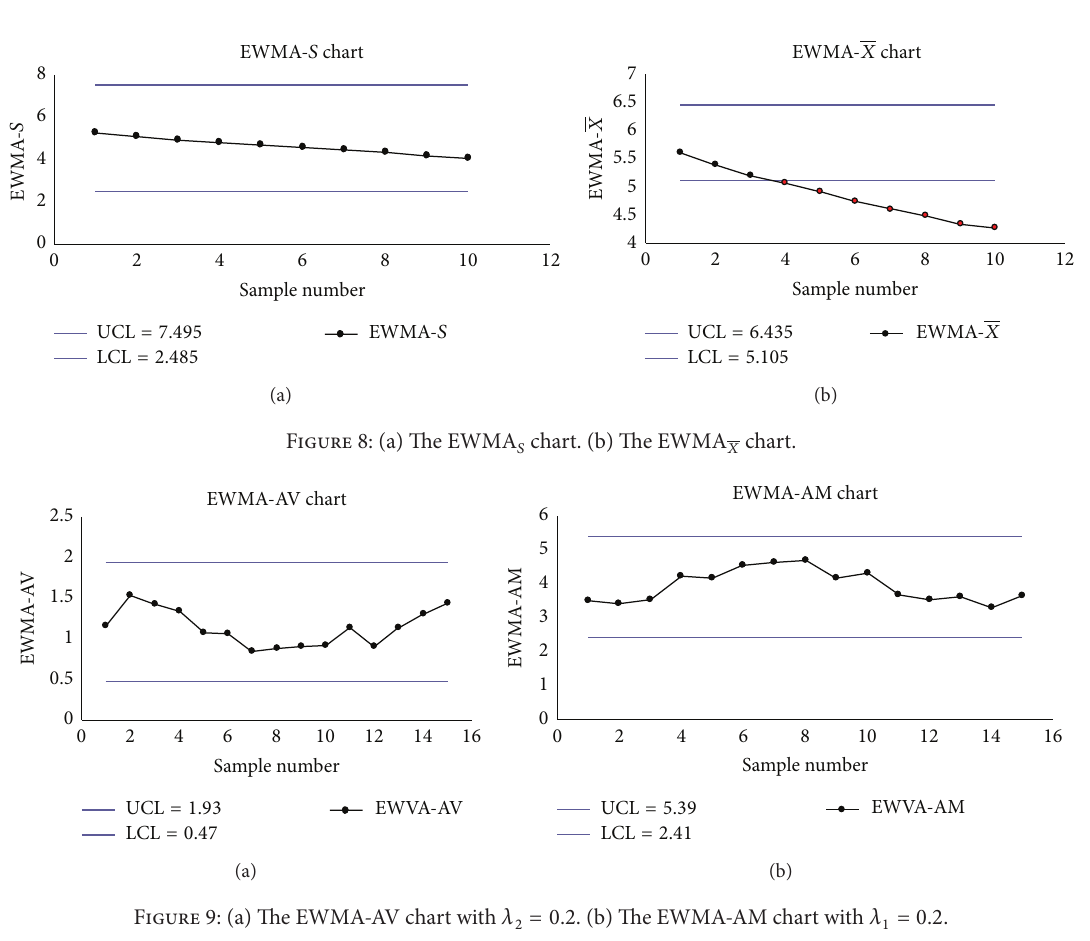
Figure 7: (a) The transformed Shewhart 𝑆 chart. (b) The transformed Shewhart 𝑋 chart.